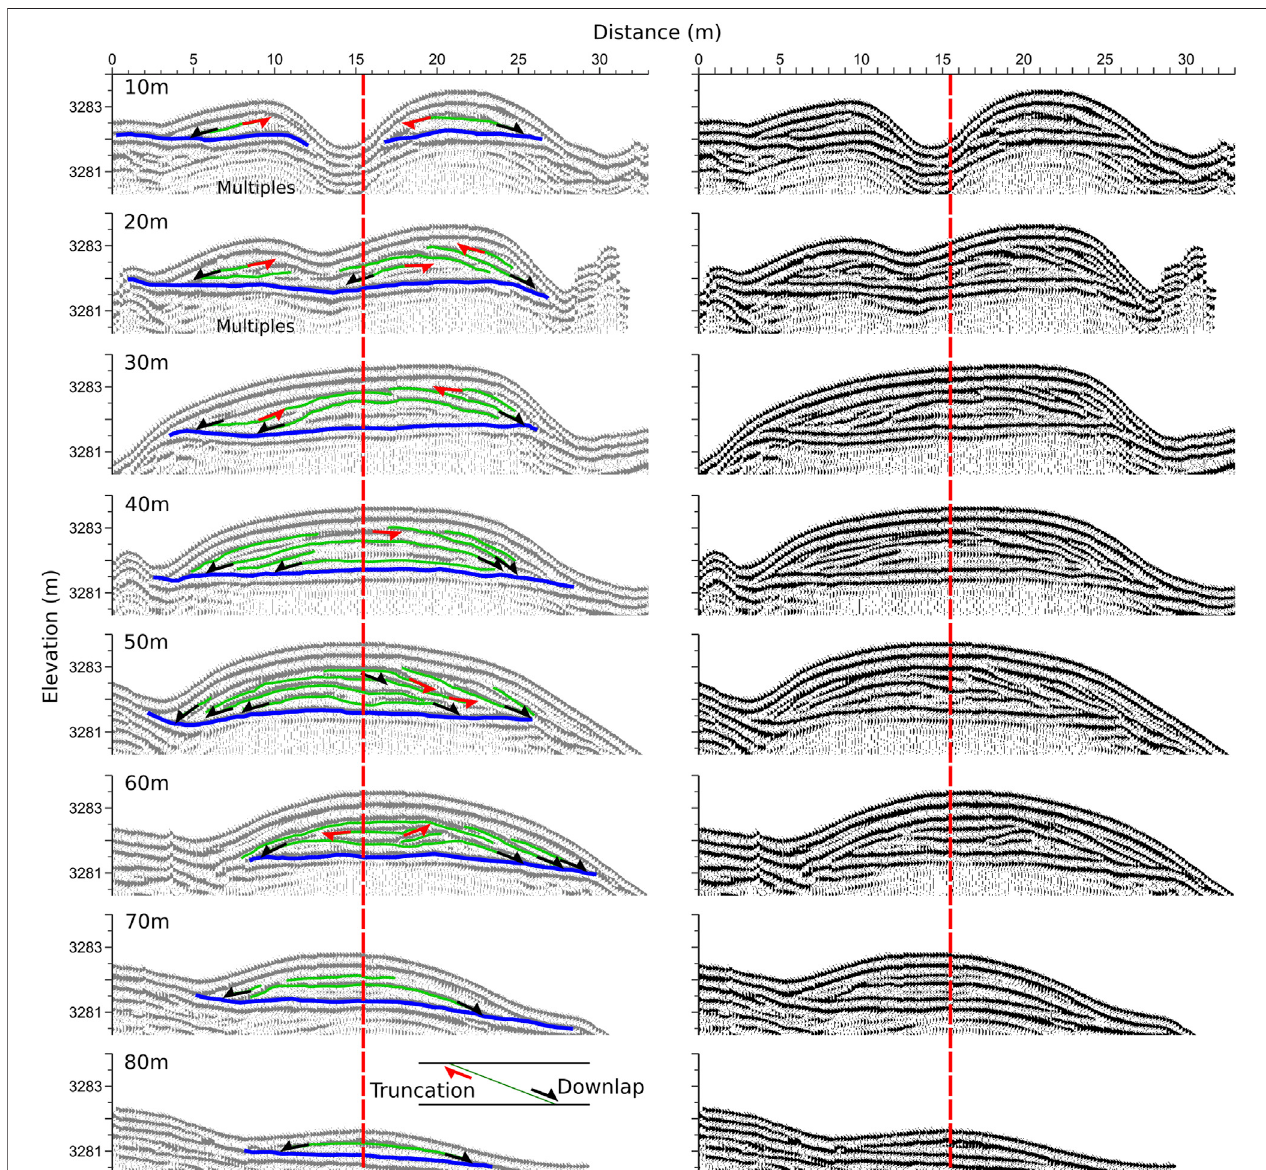
FIGURE 3 | Ground-penetrating radar transect at 10 m intervals perpendicular to the NW-SE bisect. Transects are shown from SE to NW going from left to right. The vertical axis is exaggerated by a factor of 2.5. The extracted base is denoted by the thicker blue line and interpretations of the internal bounding surfaces are shown by thinner green lines. The red dotted line indicates the intersection with the NW to SE bisect ( Figure 3 ). The uninterpreted GPR surveys are shown for reference.